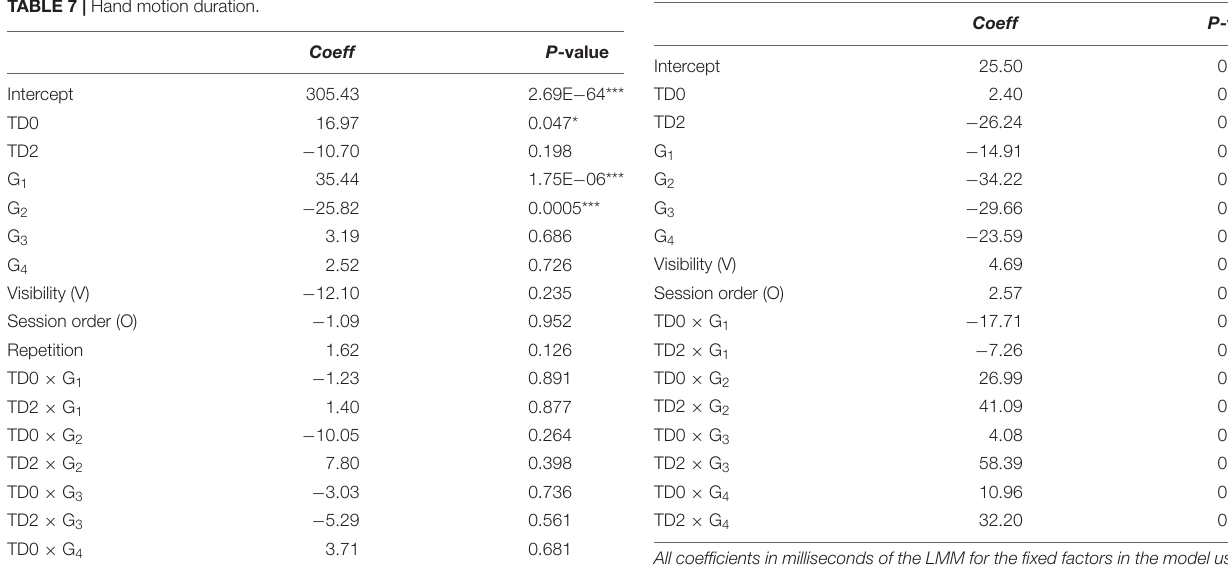
TABLE 9 | Effect of “catch trials” on hand motion